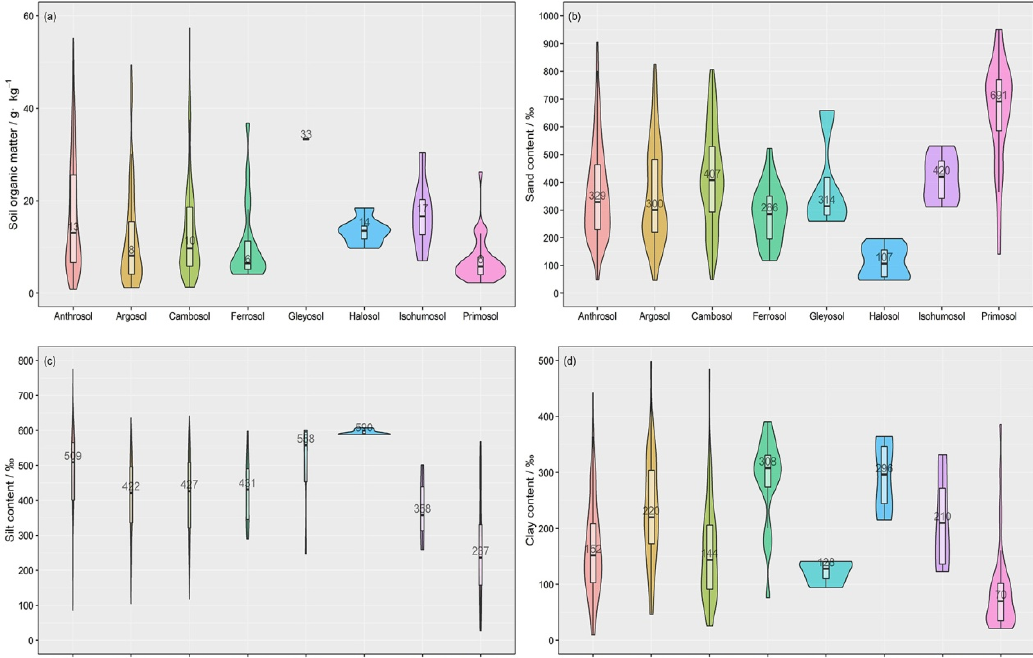
Figure 4. Violin plots of different soil profiles. The median values of each soil order are indicated by the numbers inside each violin: (a) soil organic matter, (b) sand, (c) silt, and (d) clay. The numbers shown inside each violin are the median values of each soil order.